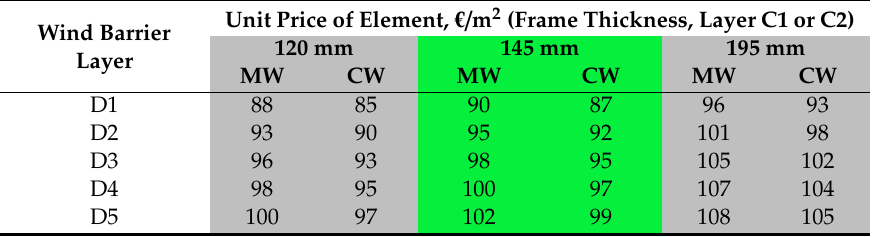
Table 9. Unit prices of prefabricated timber frame insulation elements with di ff erent insulation (MW, CW) and wind barrier materials (D1–D5) without facade materials. See Table 1 for description of layers D1 ... D5.